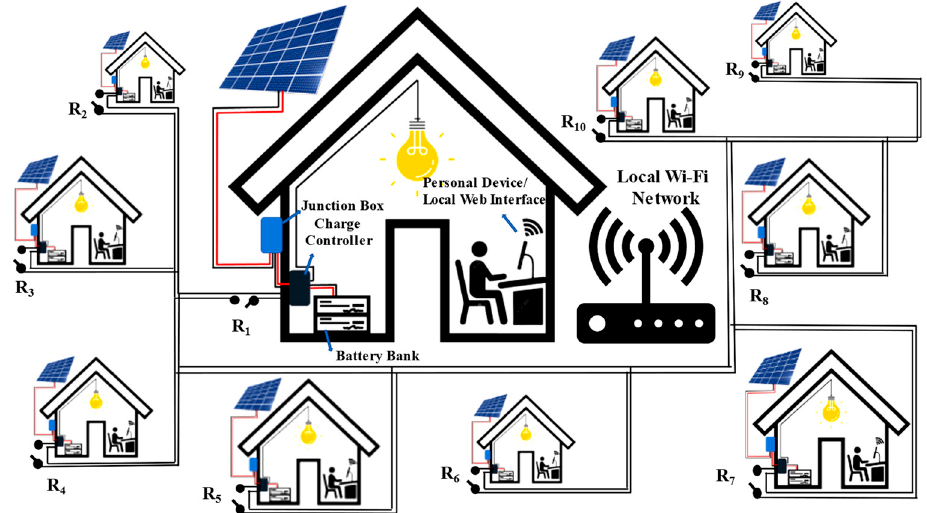
Figure 4. Micro ‐ grid configuration of proposed P2P Energy trading system [16] . Figure 4. Micro-grid configuration of proposed P2P Energy trading system